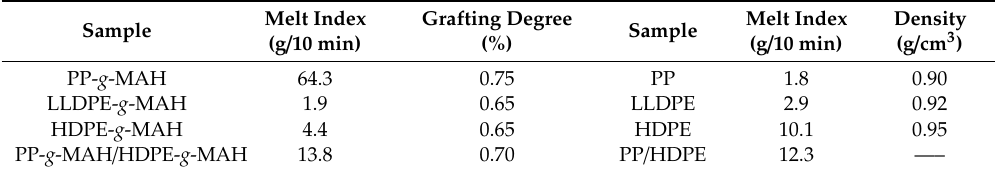
Table 1. Characteristics of the materials